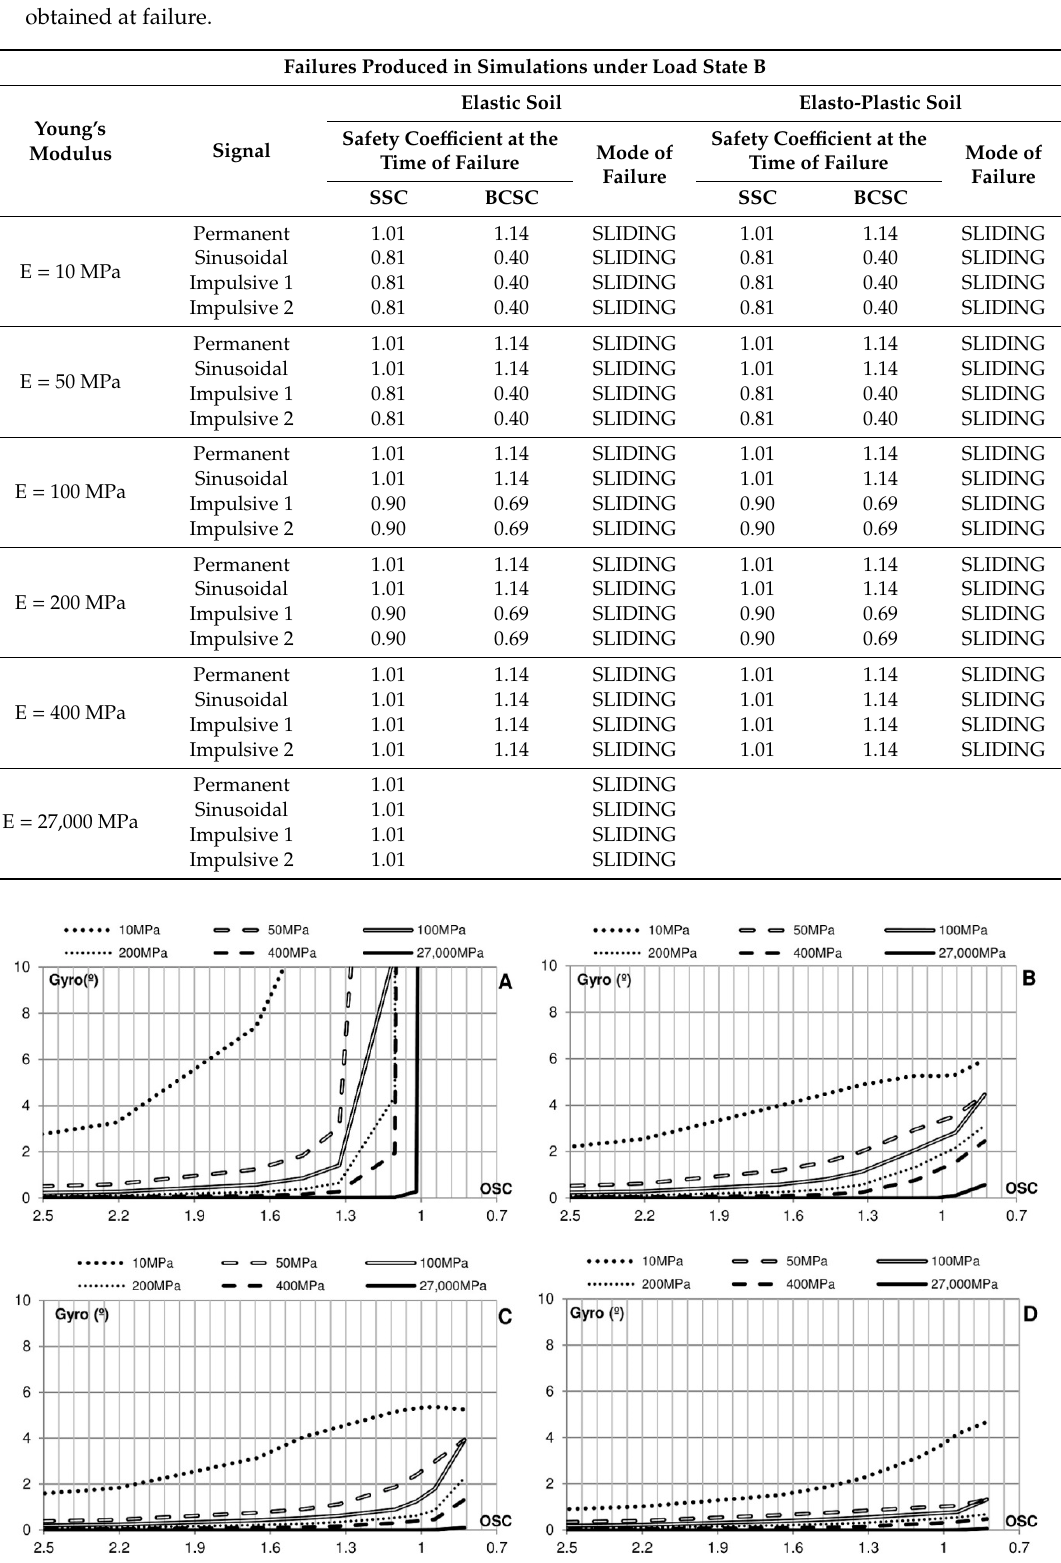
Figure 21. Wall rotation as a function of Overturning Safety coefficient (OSC) and Young’s modulus, assuming elastic soil. ( A ) Permanent; ( B ) Sinusoidal; ( C ) Impulsive 1; ( D ) Impulsive 2.